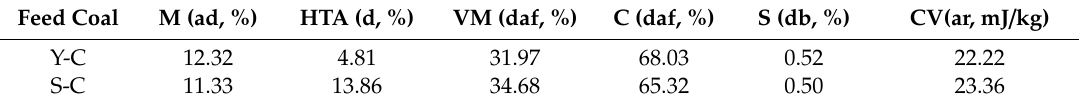
Table 1. Proximate analyses of feed coals from Shenhuo and Yihua power plants. Y-C, feed coal